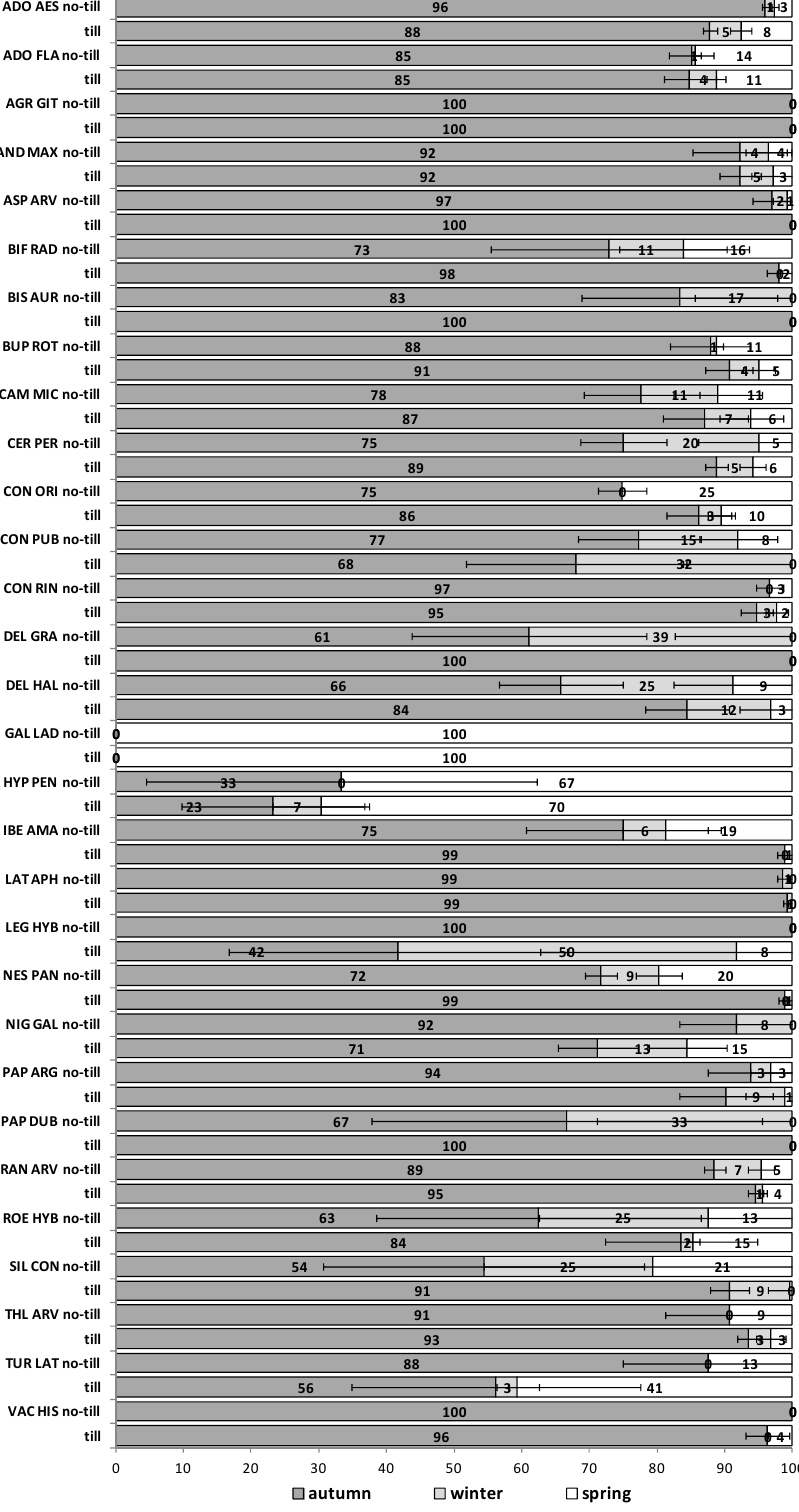
Figure A5. Relative Emergence patterns of 30 RAPs in autumn, winter, and spring during the second season (2014 / 2015) for seeds sown in 2013 (S2) in an arable field trial in Spain. Bars represent standard error. Two burial conditions are shown: 1 cm burial depth without soil disturbance (no-till) and 1–10 cm depth with annual autumnal soil disturbance (till).